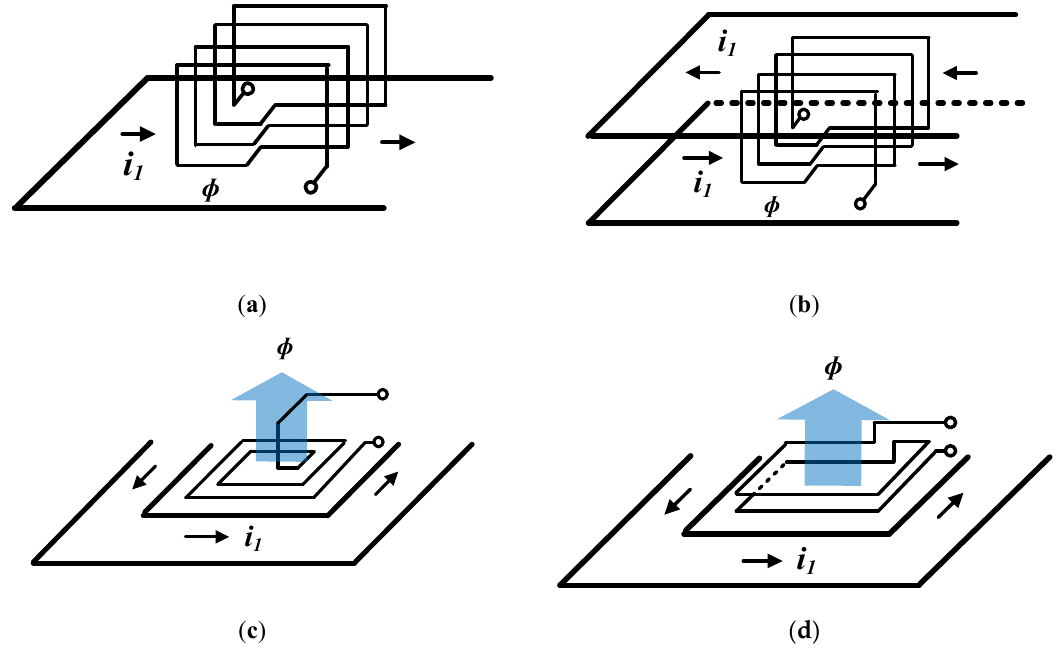
Figure 3. Magnetic-field flow through a ( a ) model-1: pick-up coil with conductor trace on one side; ( b ) model-2: pick-up coil with conductor trace on two sides; ( c ) model-3: spiral coil with conductor trace on three sides and ( d ) model-4: rectangular coil with conductor trace on three sides.